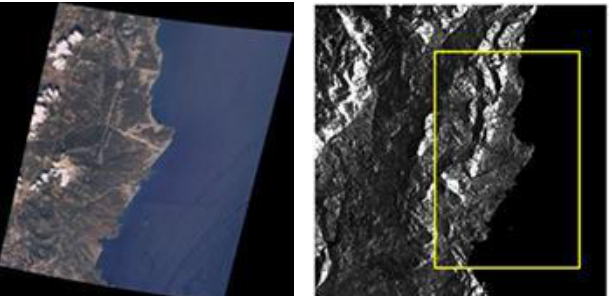
Figure 2. RASAT mosaic image (left), SENTINEL-1A image